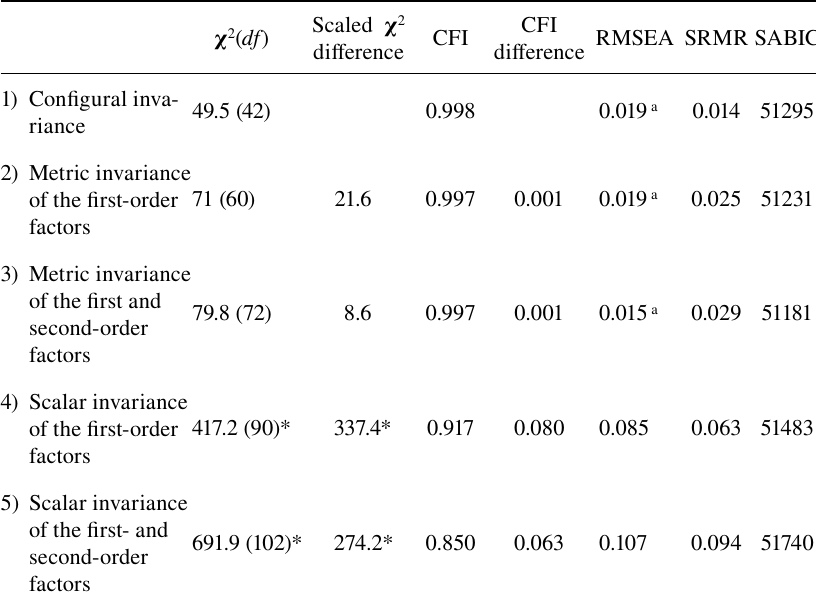
Results of Invariance Tests of a Second-Order Factor Model of